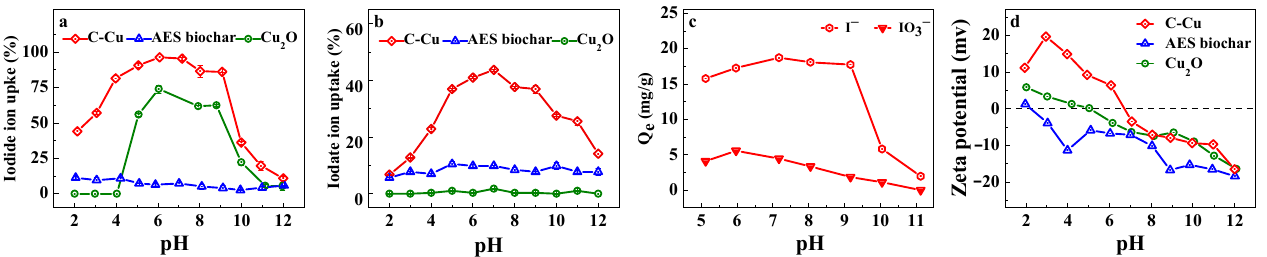
Table 5. In acid solutions, the nanoparticles on the C-Cu leached by up to 26.8% at pH